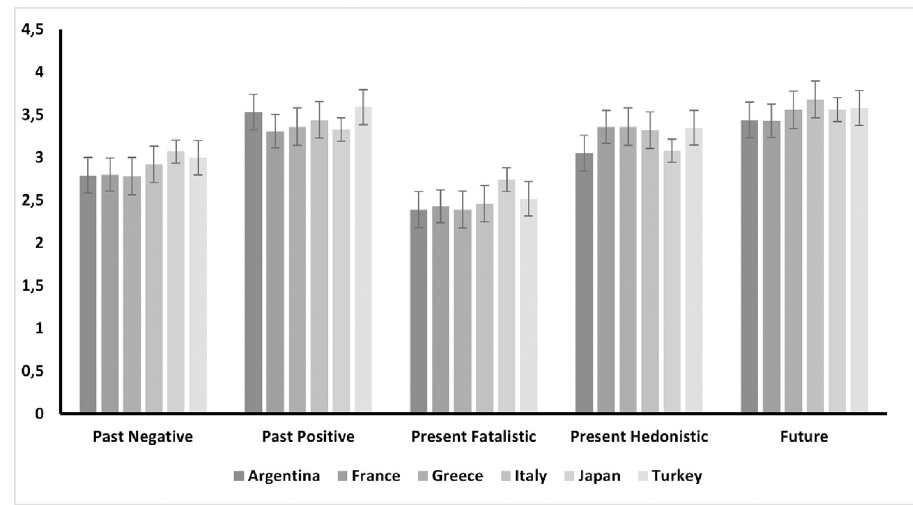
Fig 3. Average scores on the Zimbardo Time Perspectives Inventory subscales for each